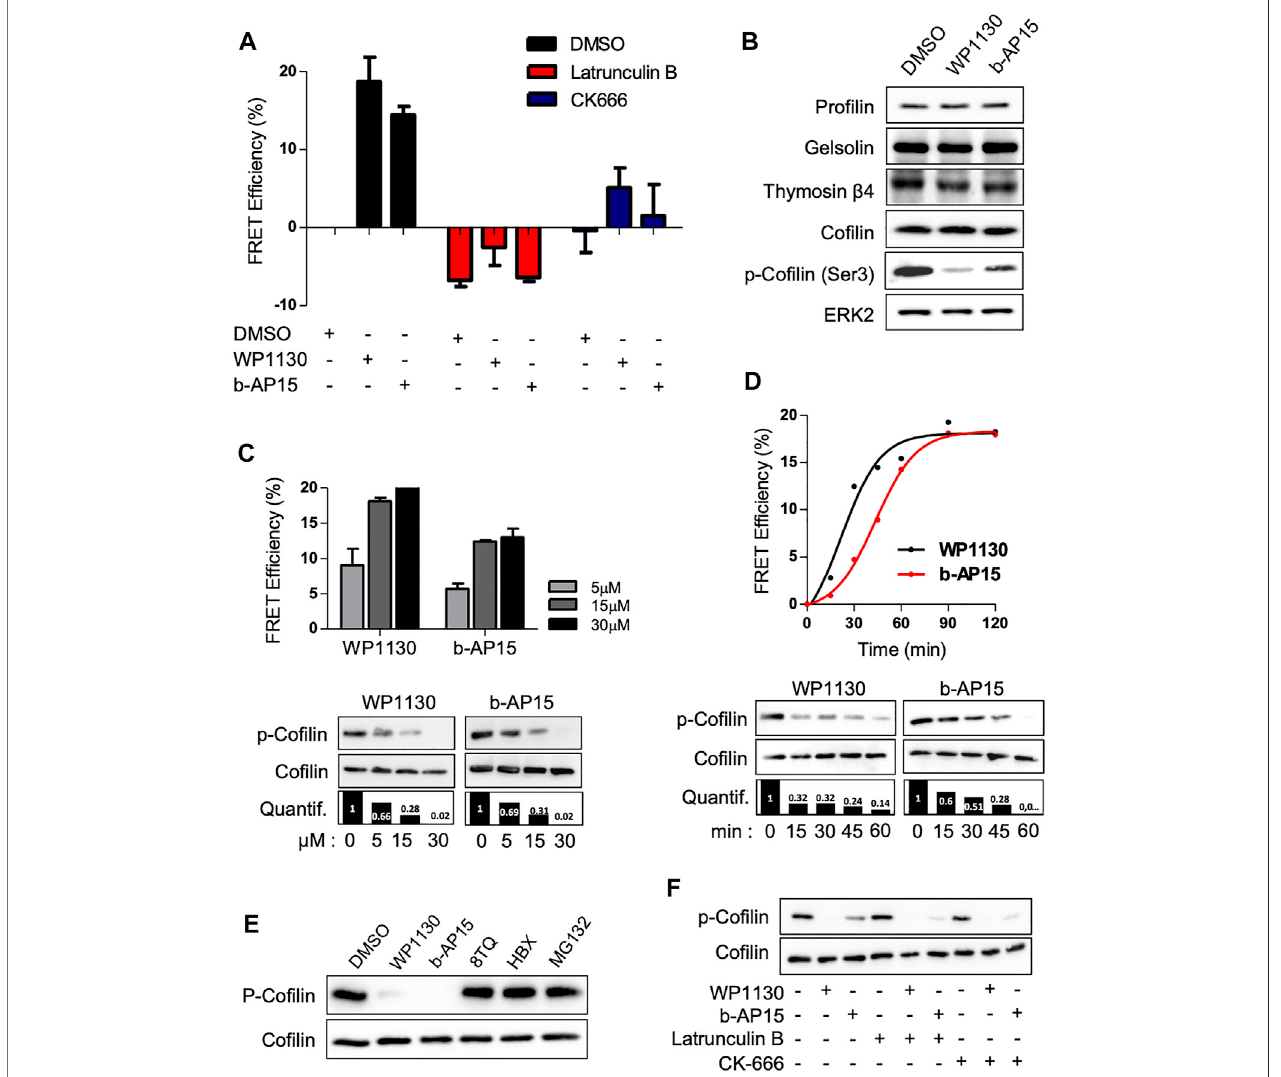
FIGURE3| DUB inhibitioninduces co fi lindephosphorylation. (A) Analysisofactin FRETef fi cienciesonACT celllinepre-treated with500 nMLatrunculinBor5 µM CK-666 for 1 h prior addition of 15 µM of WP1130 or b-AP15 for one additional hour. Data are expressed as the percentage of FRET ef fi ciency between DMSO-treated andcompound-treatedcells.Graphsaremean ± SDof n (cid:2) 3independentexperiments. (B) ImmunoblotanalysisshowingtheeffectofWP1130andb-AP15(1 h,15 µM) on the levels of actin sequestering proteins. Membranes were probed with the indicated antibodies and anti-ERK2 as loading control. (C) Effect of increasing amounts of WP1130 and b-AP15 on the phosphorylation of co fi lin at Ser3. Membranes were probed with the indicated antibodies and quanti fi ed against total co fi lin signal (bar graph). Upper panel, bar graphs show actin FRET ef fi ciencies recorded on ACT cells upon the same treatment (mean ± SD of 3 independent experiments). immunoblotanalysisoflysatesobtainedfromcellstreatedasabove. (D) Time-courseanalysisofco fi linSer3phosphorylationfollowingtreatmentwith15 µMofWP1130 and b-AP15 for the indicated time. Membranes were probed with the indicated antibodies and quanti fi ed against total co fi lin signal (bar graph). Upper panel, the graph shows thecorrespondingeffectson actin FRETef fi ciencies. (E) WP1130 and b-AP15, but not 8TQ, HBX41108 and MG132, reduce co fi lin Ser3phosphorylation levels. Immunoblotting were performed on lysates from Jurkat cells treated with 15 µM of the indicated compound for 30 min. (F) Immunoblot analysis of co fi lin Ser3 phosphorylation on cells treated with 500 nM Latrunculin B or 5 µM CK-666 prior addition of 15 µM of WP1130 and b-AP15 for 30 min.